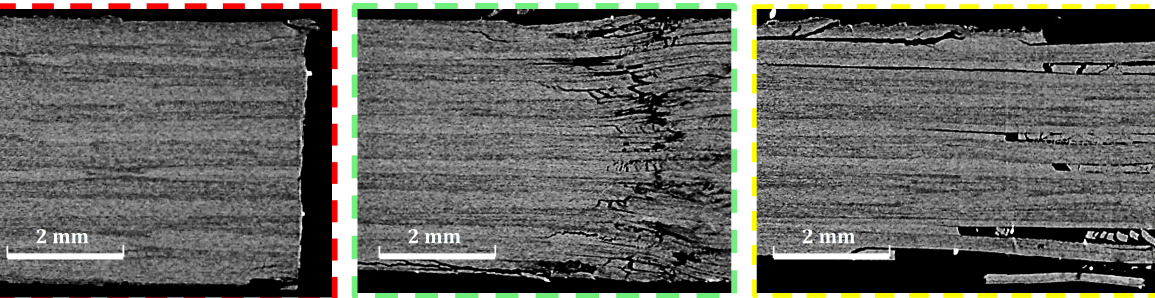
Figure 8. Computed Tomography scan of the first alternative (color code is in Figure 7).